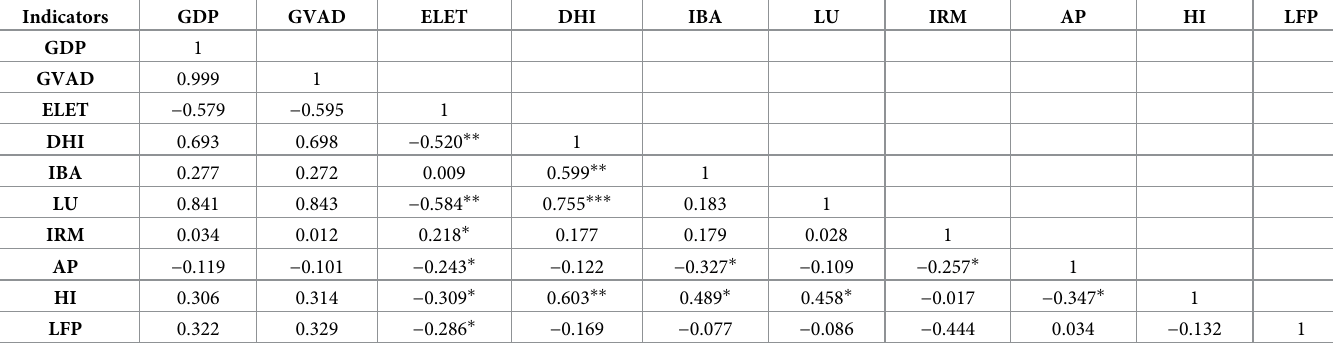
Table 6. Correlation matrix for Central and Eastern Europe regions.